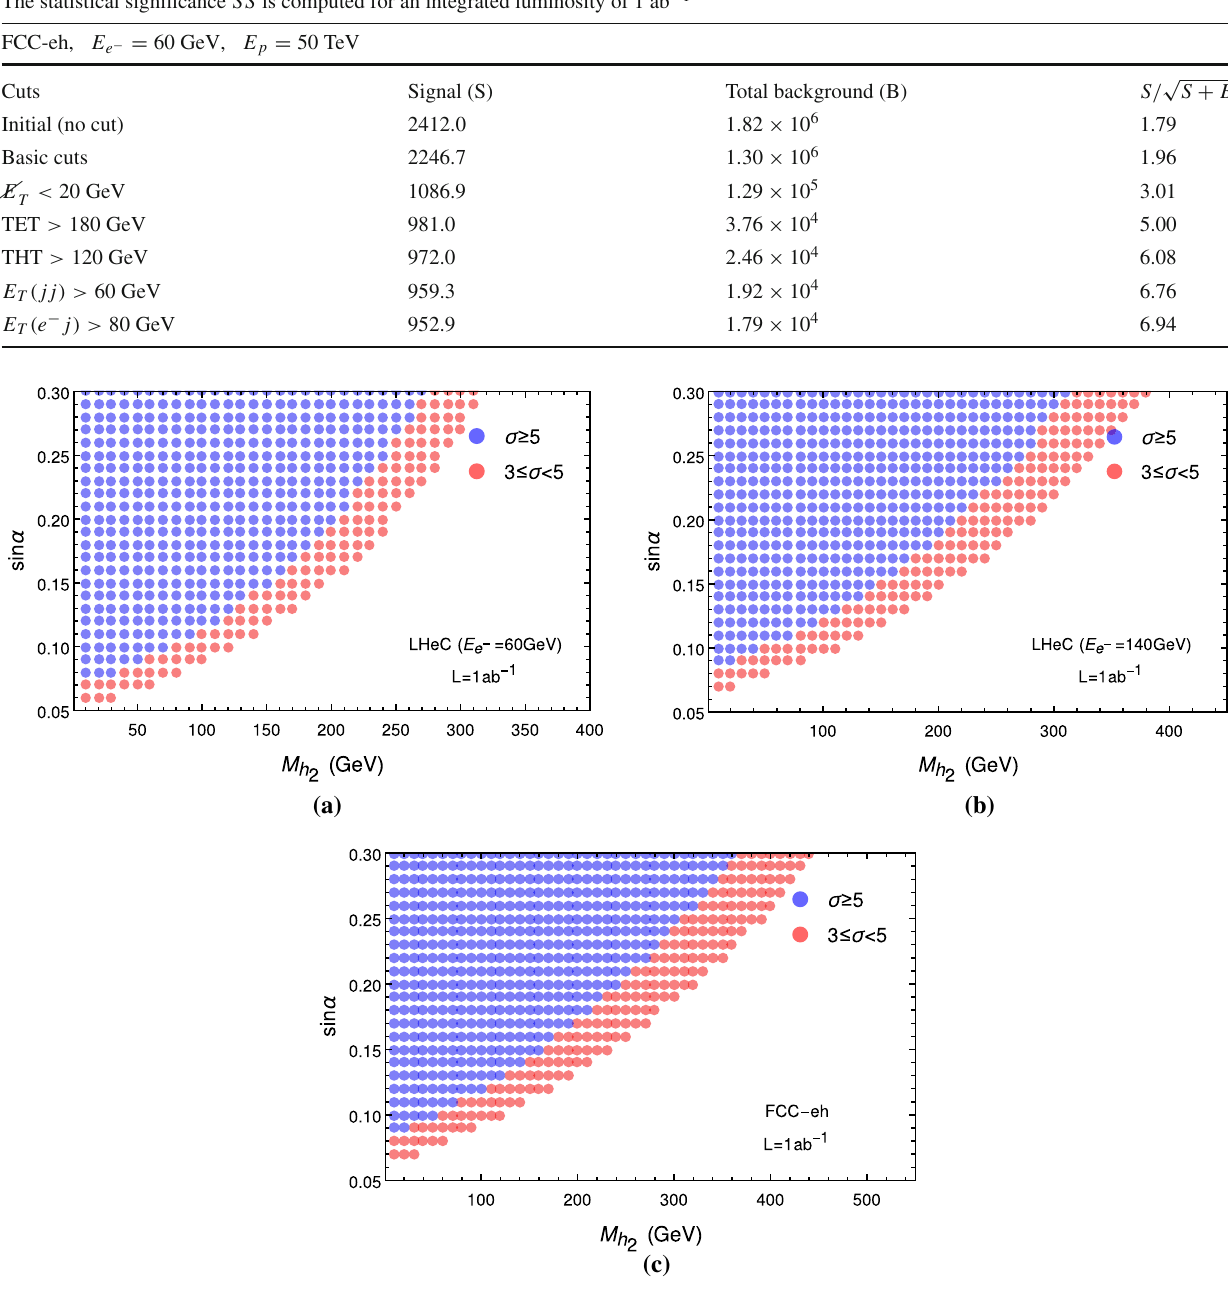
Fig. 7 3 σ and 5 σ detection potential regions for the signal-1 at the LHeC with E e − = 60 GeV ( a ), LHeC with E e − = 140 GeV ( b ) and FCC-eh ( c ) with an integrated luminosity of 1 ab − 1 ,